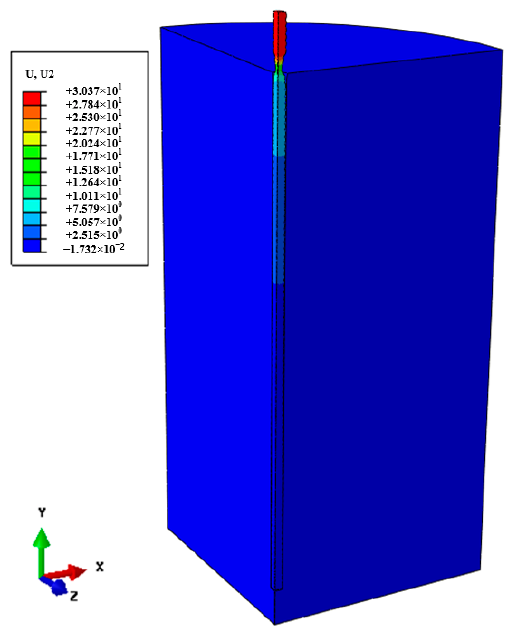
Figure 10. L840 model failure diagram.